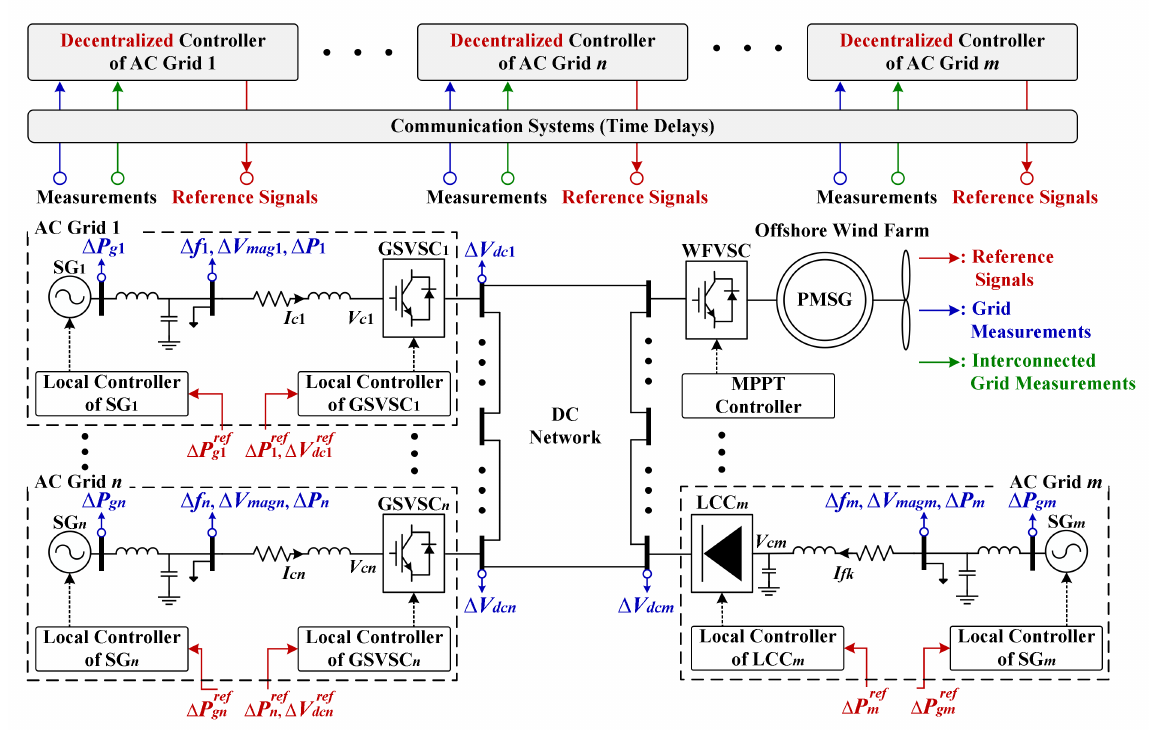
Figure 1. A schematic showing optimal control of hybrid MTDC-linked grids and